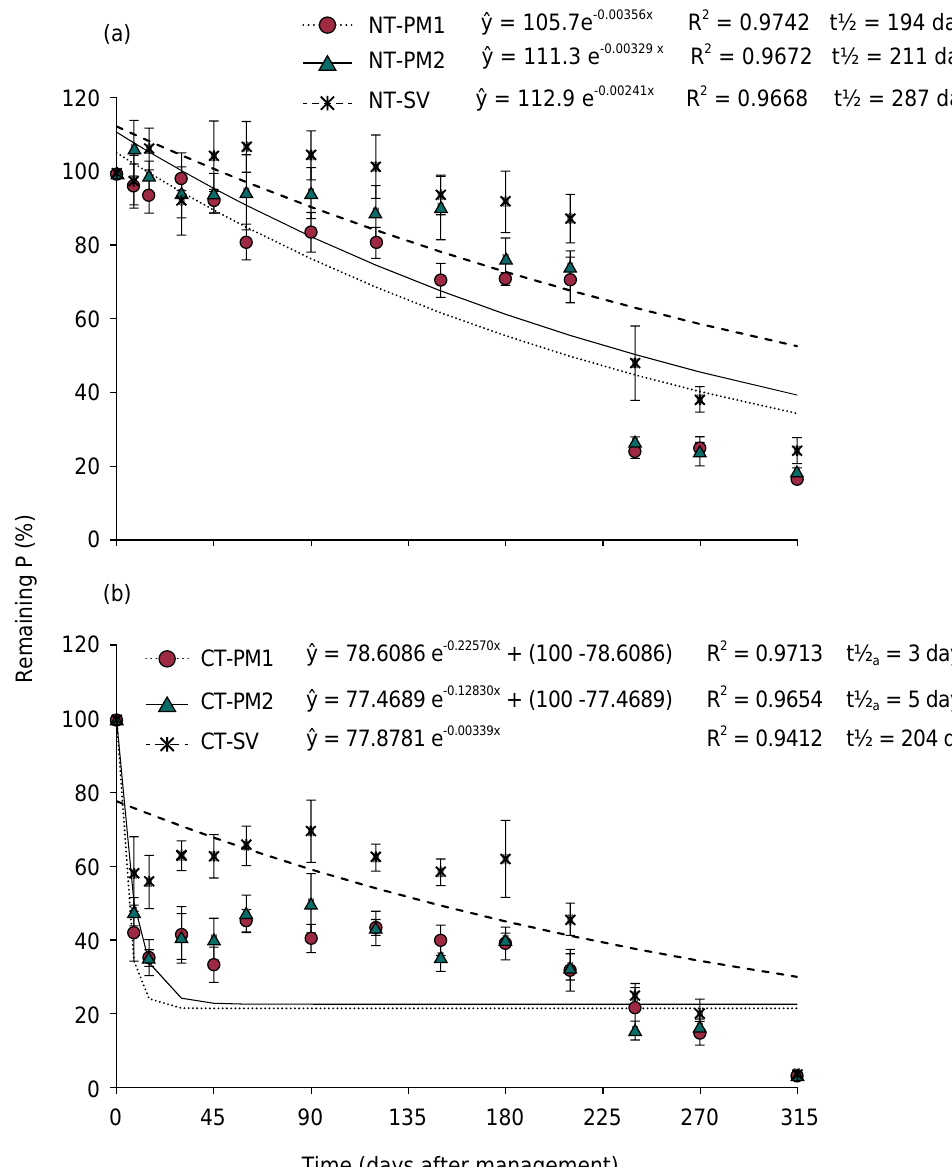
Figure 7. Remaining phosphorus of aboveground phytomass after management of three mixtures of cover crops in mango interrows in Petrolina, Pernambuco, Brazil (PM1 = 75 % leguminous species + 25 % grass and oilseed species; PM2 = 25 % leguminous species + 75 % grass and oilseed species; and SV = spontaneous vegetation) under two soil tillage systems (NT = no tillage (a); CT = conventional tillage (b); t½ = half-life time; t½ a = half-life time of more easily decomposable compartment. Bars represent the standard error of the